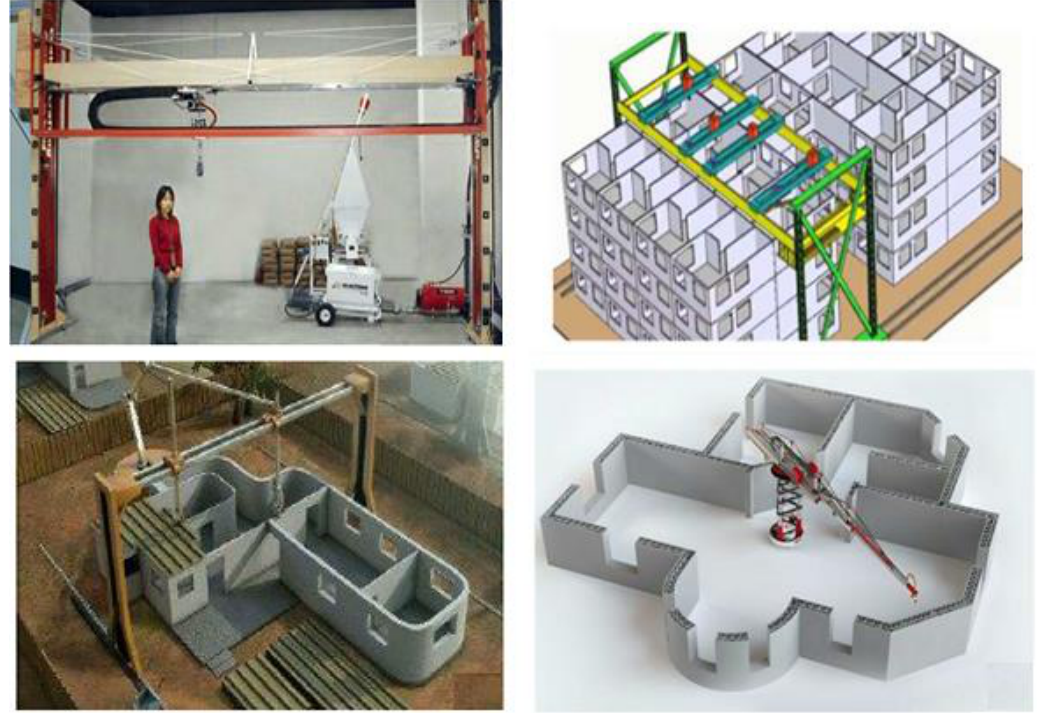
Figure 5. Different types of configuration of CC machine [6, 2]. Table 1. The effects of CC technology application on decreasing each part of building projects costs.